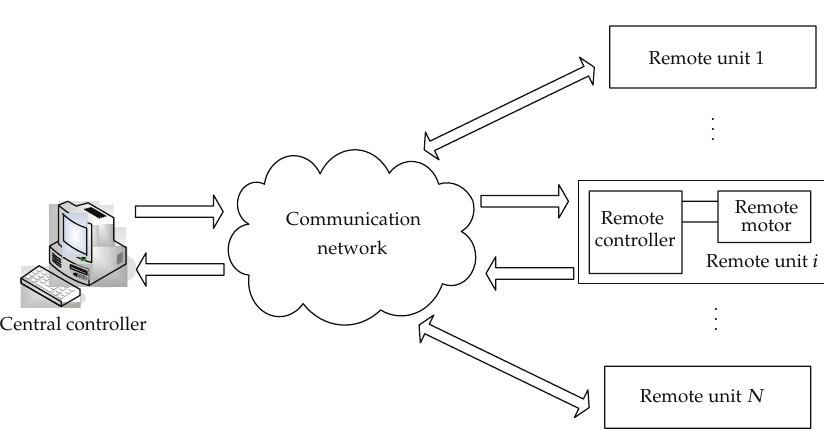
Figure 2: The diagram of a typical networked servo